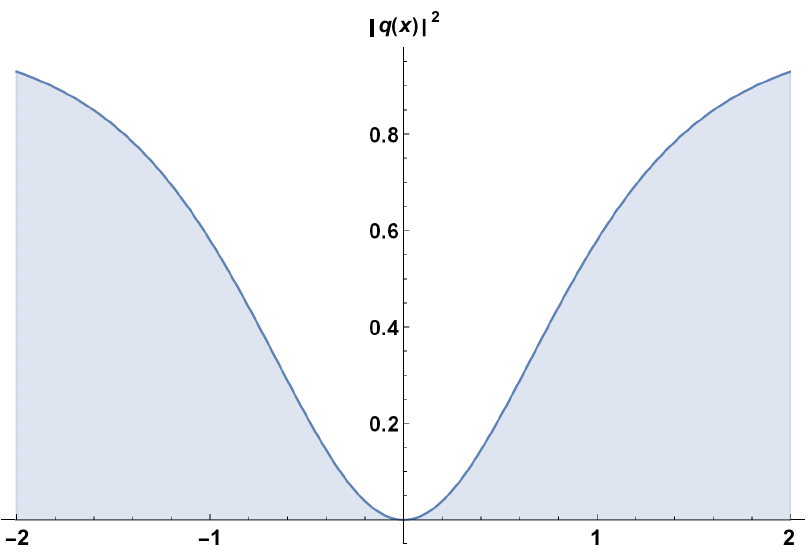
Figure 1. Profile of quiescent dark optical soliton in polarization controlled